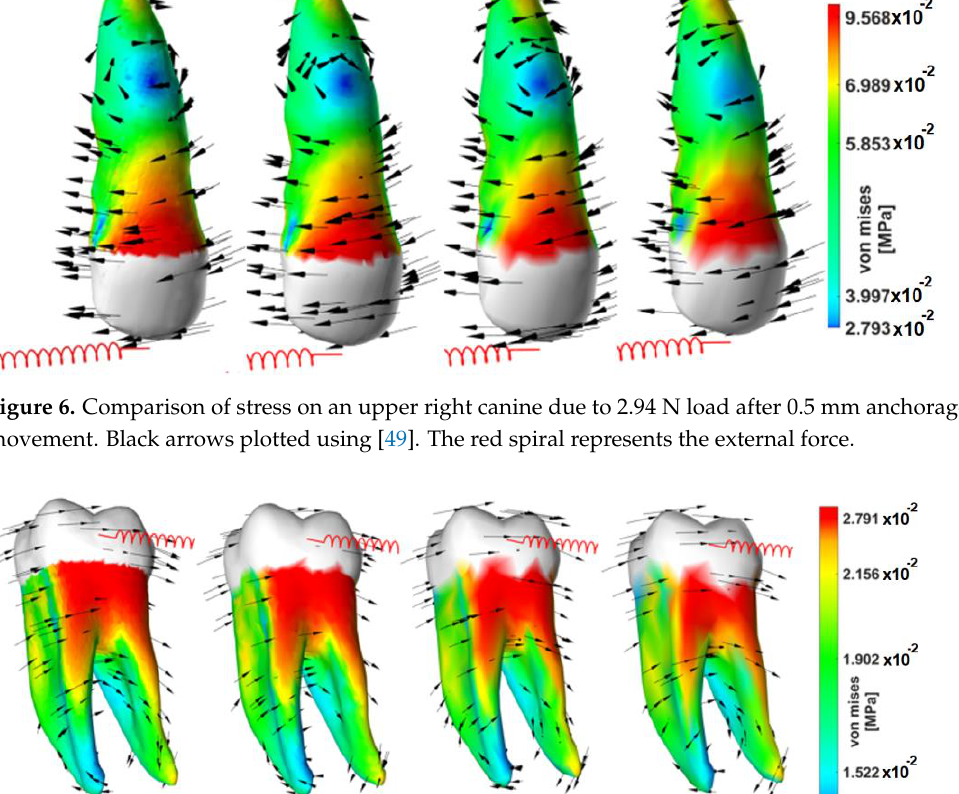
Figure 7. Comparison of stresses and movement for various facet resolutions in mandibular right molar after anchorage movement of 0.5 mm. Black arrows plotted using [49]. The red spiral represents the external force.